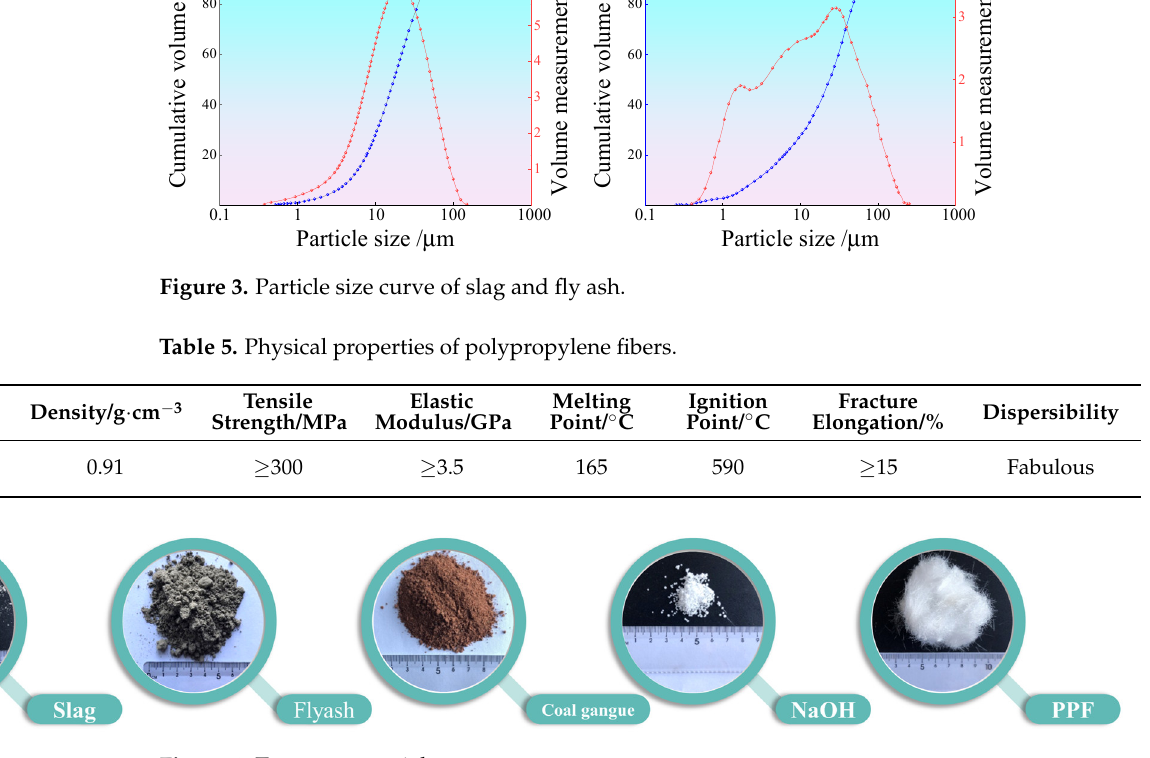
Figure 2. XRD patterns of slag and fly ash.